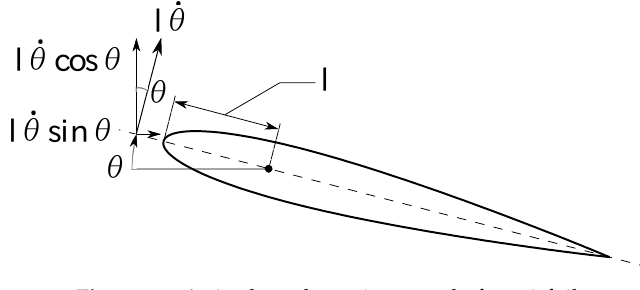
Figure 23. Attitude and rotation speed of an airfoil.